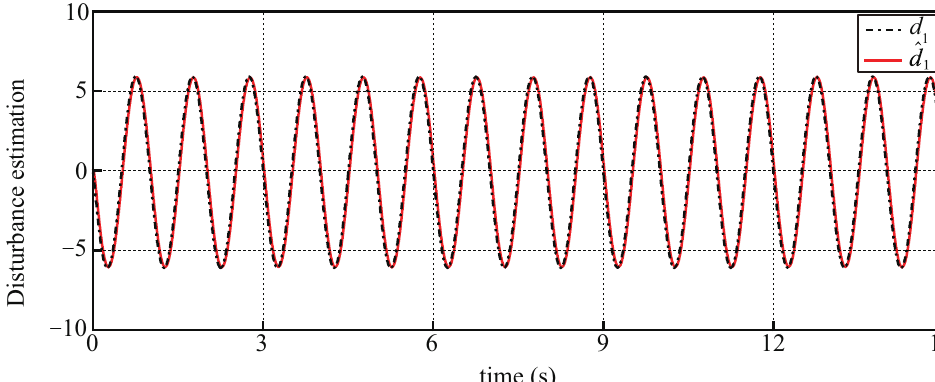
Figure 6. Estimation performance of d 1 via RESO.